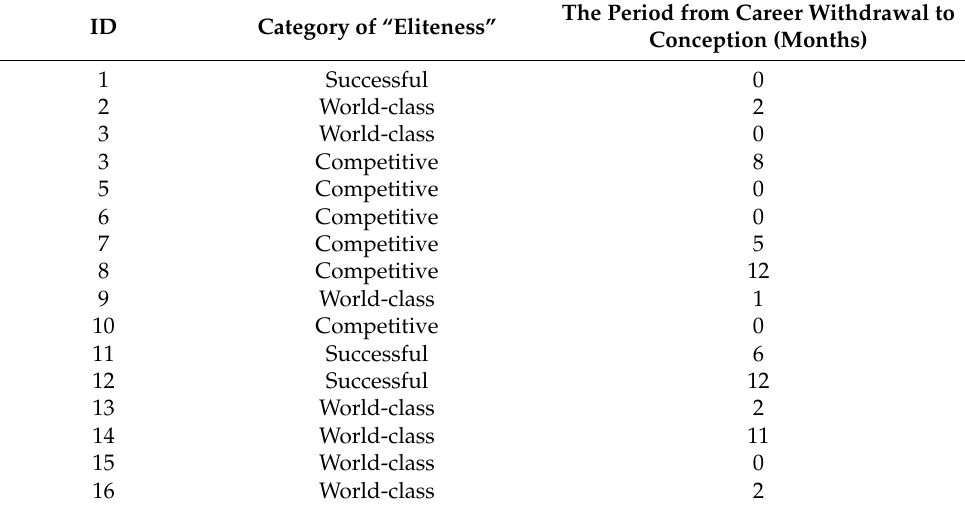
Table 1. Categories of judo athletes “eliteness” * and the periods between their withdrawal from regular judo-specific high-intensity training sessions and the beginning of their first pregnancy. The Period from Career Withdrawal to ID Category of “Eliteness”